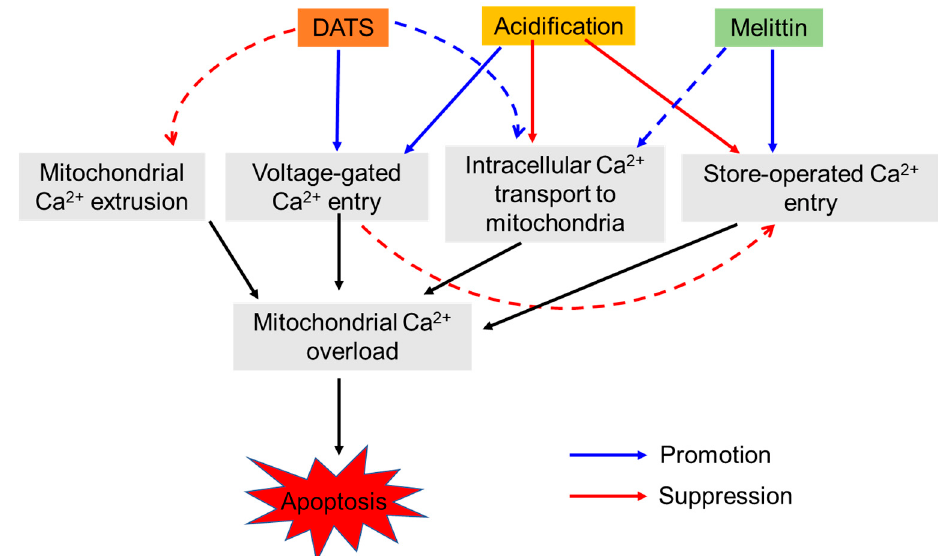
Figure 8. A schematic summary of the present study. Both DATS and melittin induce mitochondrial Ca 2+ overload and apoptosis in melanoma cells. However, different pathways seem to contribute to the effects, depending on the apoptotic stimuli and the extracellular pH. Specifically, at neutral pH, the extracellular Ca 2+ entry is predominant. Melittin primarily uses store-operated entry (SOCE), while DATS mainly utilizes yet unknown extracellular Ca 2+ entry pathway possibly including voltage-gated Ca 2+ entry (VGCE). Under acidic pH, SOCE is mitigated. In turn, intracellular Ca 2+ entry plays a substantial role in the effects of melittin and DATS. Increased Ca 2+ transport from the intracellular stores (e.g., the endoplasmic reticulum) to the mitochondria and decreased mitochondrial Ca 2+ extrusion could contribute to the event. Under the acidic conditions, DATS, but not melittin, seems to utilize VGCE as the primary route for Ca 2+ entry, leading to mitochondrial Ca 2+ overload and apoptosis. The VGCE could exacerbate SOCE inactivation, and Ca 2+ dysregulation due to the loss of the negative membrane potential, the driving force transporting extracellular Ca 2+ into inner cells through SOCE.